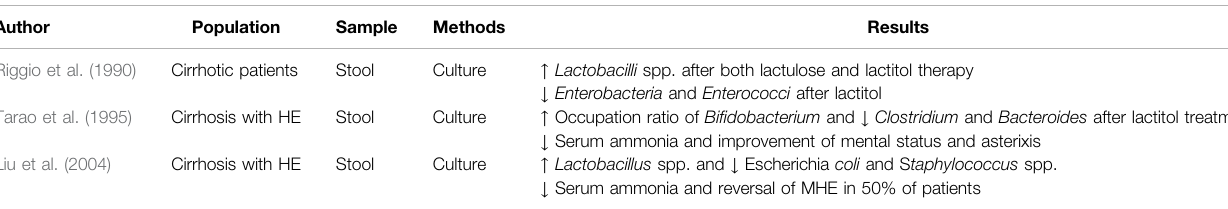
TABLE 1 | Culture-based studies on gut microbiome in human